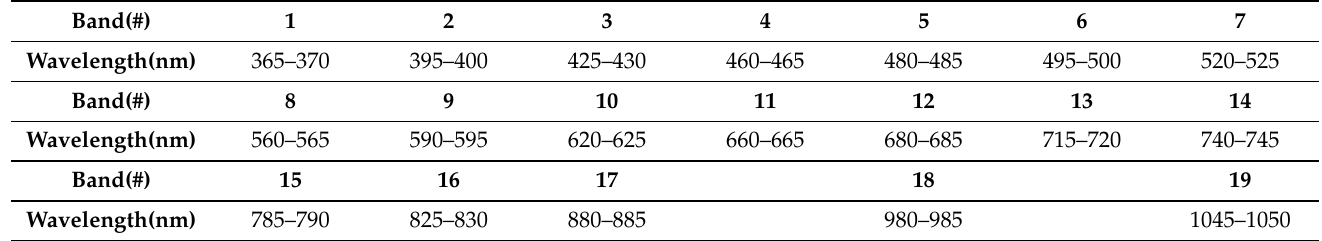
Table 1. Spectral band number with its corresponding wavelength of the LED lights.